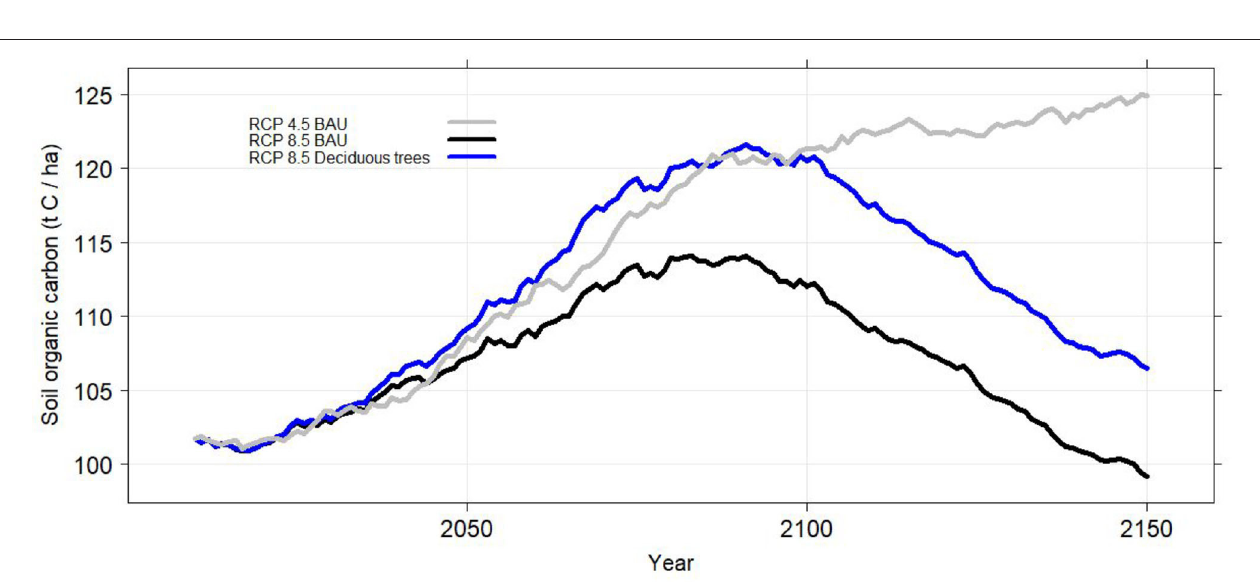
FIGURE 6 | Forest adaptation to climate change via replacement of coniferous with deciduous tree species, depending on expected climatic conditions. The used climate scenario (RCP 8.5) reflects a strong warming trend. The initial conditions are presented for the year 2010 (upper panel, left) , the distribution of tree species in 2050 (upper panel, right) , 2100 (lower panel, left) , and 2150 (lower panel, right) is shown. The color gradient describes the proportion of deciduous forests from 0 (yellow), 20, 40, 60, 80, 100% (increasing darkness of greens).